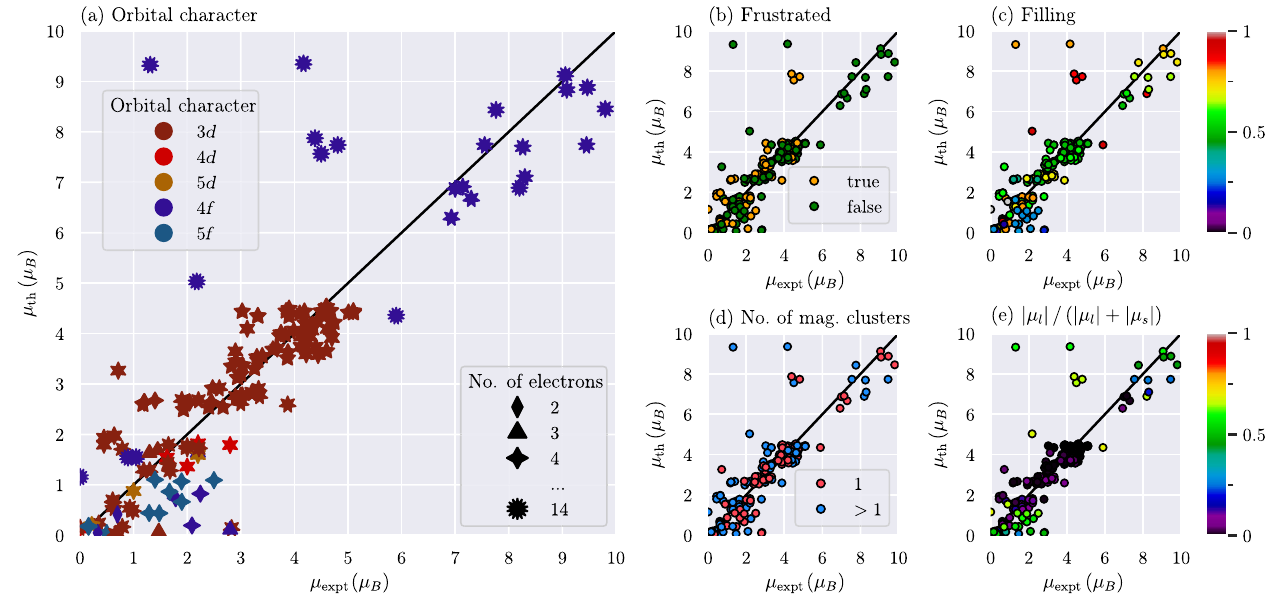
FIG. 6. Average magnetic moment per site of the CMP þ SDFT minimum most similar to experiment with respect to its magnetic configuration μ compared to the experimentally measured magnetic moment per site μ . (a) Color indicates the valence orbital th expt character of the magnetic site. The number of points on a star mark equals number of electrons. (b) Color indicates if the material is expected to be frustrated due to odd numbered rings of antiferromagnetic bonds. (c) The color bar shows the filling of the valence orbital of the magnetic site. (d) Color indicates if a single cluster or multiple clusters are magnetic in the material. (e) The color bar shows the μ = ðj μ normalized orbital angular momentum contribution j μ l j l j þ j s jÞ